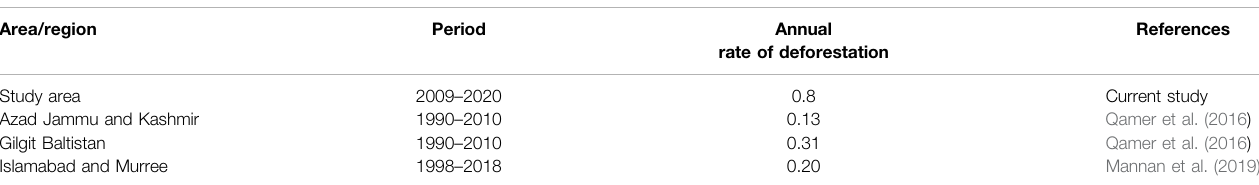
TABLE 2 | Differences in the rate of deforestation in different hilly areas of